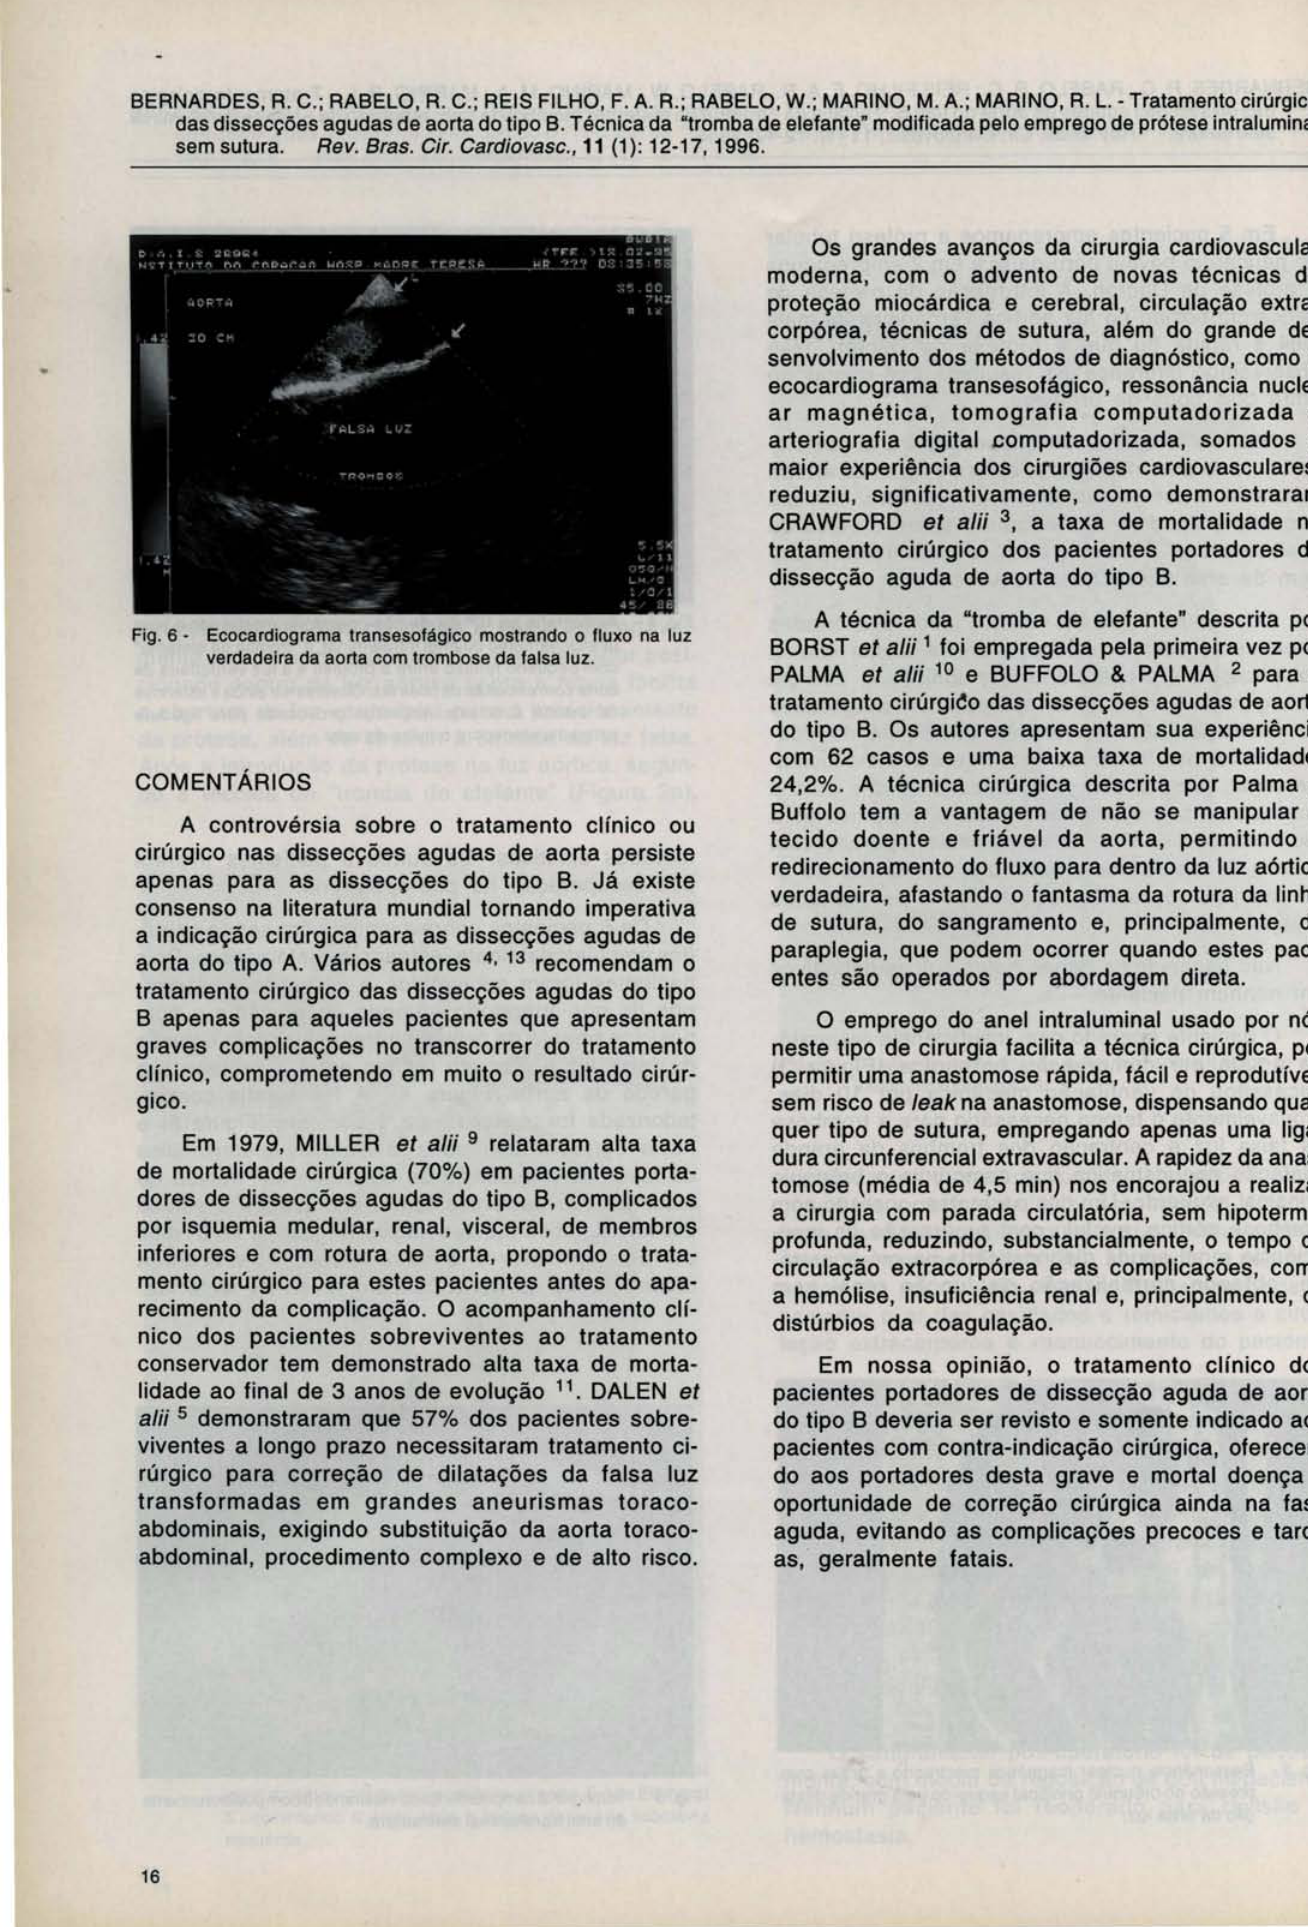
Fig. 6 - Ecocardiograma transesofágico mostrando o fluxo na luz verdadeira da aorta com trombose da falsa luz.